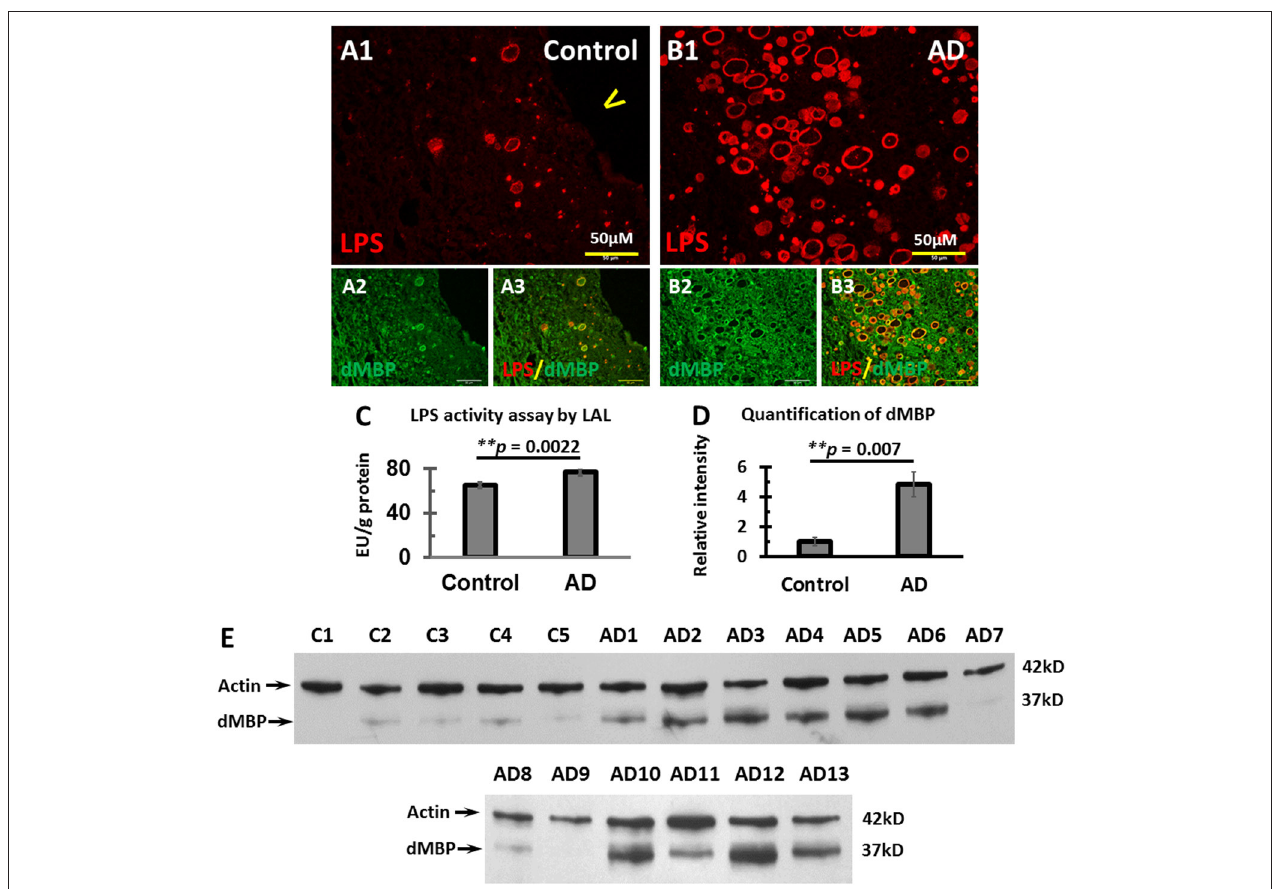
FIGURE 5 | Colocalization of LPS with dMBP, LPS LAL assay, and Western blot analysis of dMBP in the PVWM of AD and control brains. (A) LPS (A1) and dMBP (A2) in control PVWM were colocalized (A3) . (B) LPS (B1) and dMBP (B2) in AD PVWM were colocalized (B3) . (C) The LAL assay for LPS of PVWM showed significantly greater LPS activity in AD (77.3 ± 3.1 EU/g, n = 12) compared to controls (65 ± 2.1 EU/g, n = 10, p = 0.0022). (D) The dMBP band intensity in PVWM was greater in AD (4.8 ± 0.8, n = 13) compared to controls (1 ± 0.3, n = 5, p = 0.007). (E) Western blots of PVWM for dMBP and β -actin for 5 controls (C1-C5) and 13 AD samples (AD1-AD13). β -actin was used as a loading control. Note: LAL, Limulus Amoebocyte Lysate assay for LPS; dMBP, degraded myelin basic protein; LPS, lipopolysaccharide; AD, Alzheimer’s disease; Bar = 50 µ